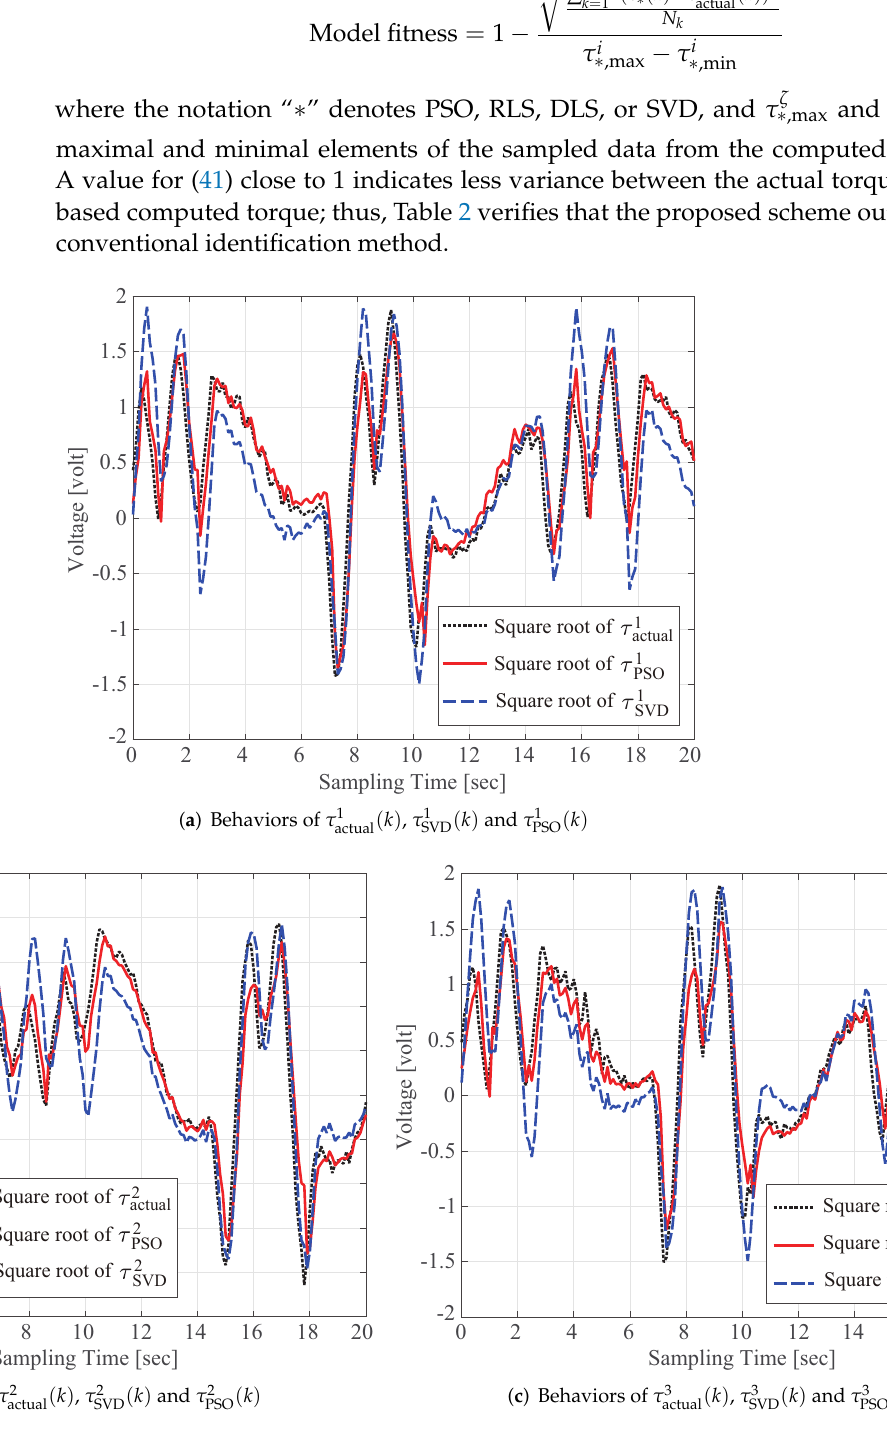
( k ) obtained from SVD- SVD